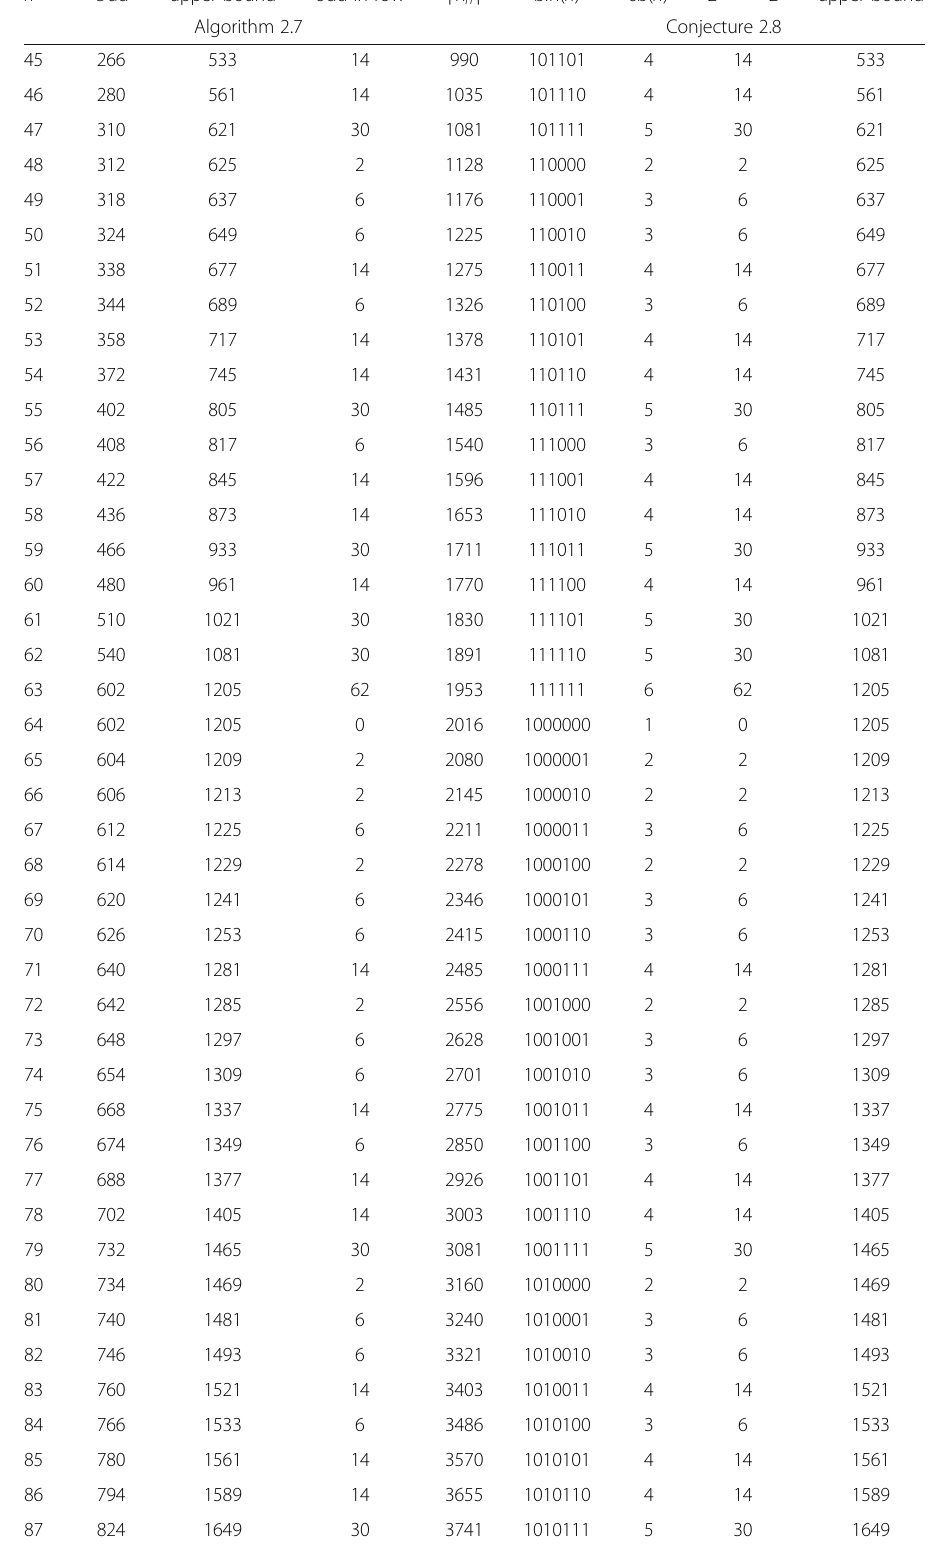
Table 2 The upper bound for the number of edges of a graph with n vertices